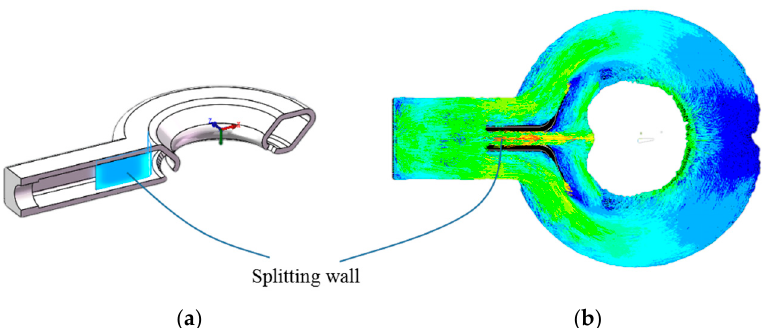
Figure 8. Structural design of annular flow channel: ( a ) sectional view and ( b ) airflow hydrodynamics simulation. Figure 9 demonstrated the actual in situ hot air flow drying device. Different from